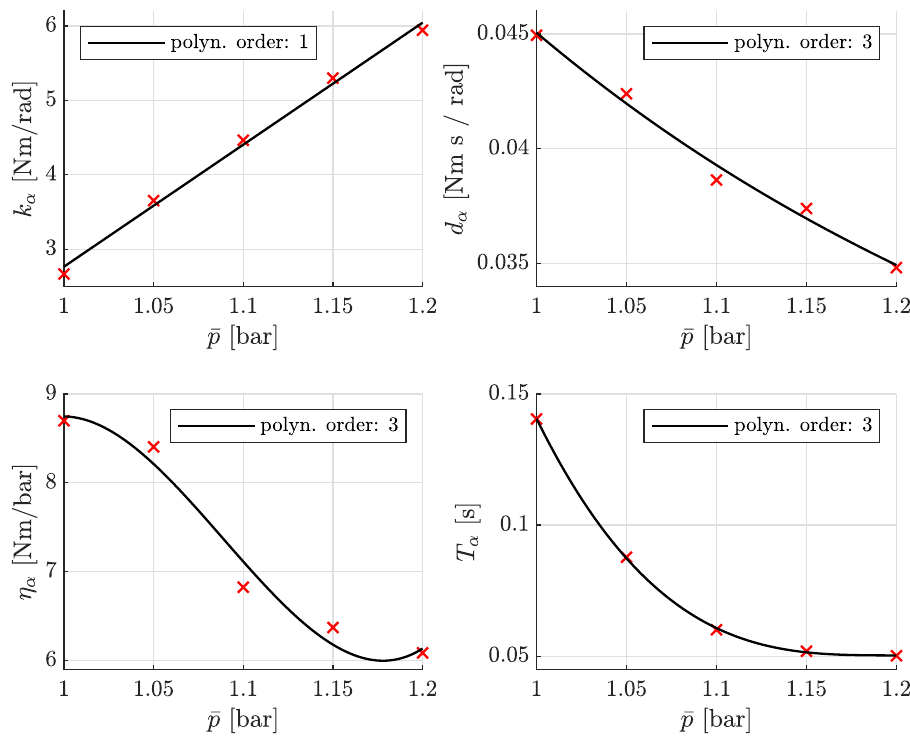
Figure 11. The parameters of the transfer function, G α ( s , ¯ p , m ) , as a function of the lower pressure level ¯ p . The red crosses indicate the parameter values from the identification experiments and the black solid lines show the first or third order polynomial fits. The stiffness parameter (top left plot) shows a linear relation with the lower pressure level, ¯ p .